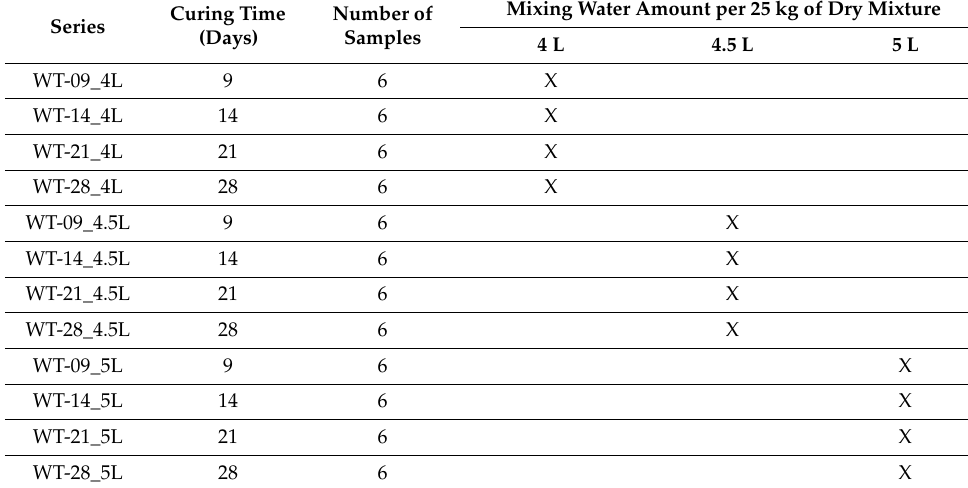
Table 2. Wrench test